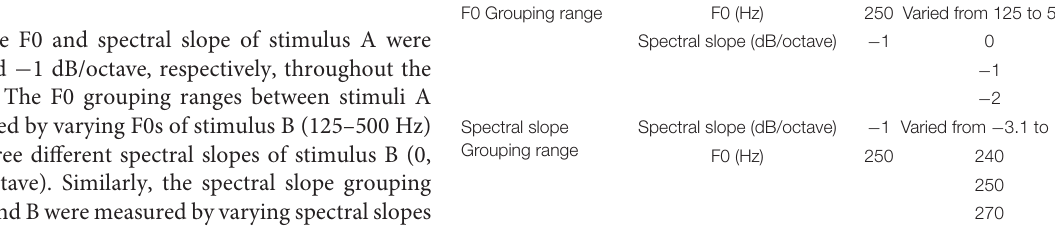
TABLE 1 | Experimental conditions of fundamental frequency (F0) and spectral slope of harmonic stimuli A and B. Measurement Parameter A B F0 Grouping